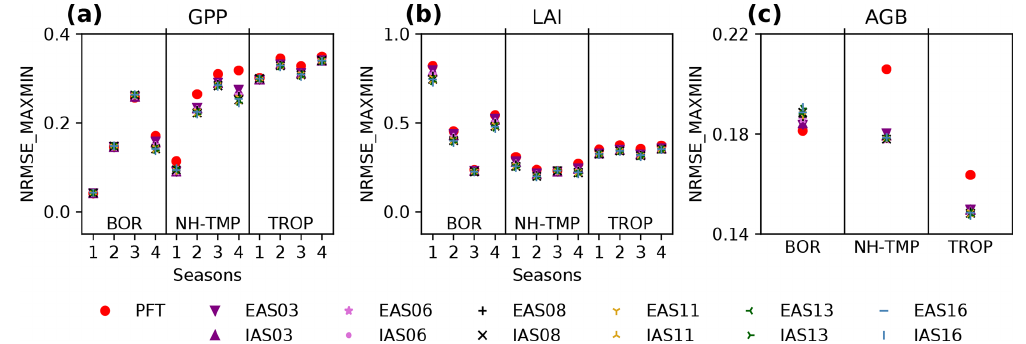
Figure 5. Evaluation of the conducted simulations (Table 1) with observation-based data by means of the normalised root mean squared error (NRMSE Max − Min , Sect. 2.3.5). Depicted are calculated NRMSE Max − Min (Sect. 2.3.5) values for each simulation for the gross primary production (GPP; panel a ), the leaf area index (LAI; panel b ), and the above-ground biomass (AGB; panel c ). The NRMSE Max − Min is calculated as the root mean squared error of observation-based data and simulation results, normalised with the range (max–min) of the according variable for each of the selected regions (Table 2) and for LAI and GPP also for each of the four seasons.